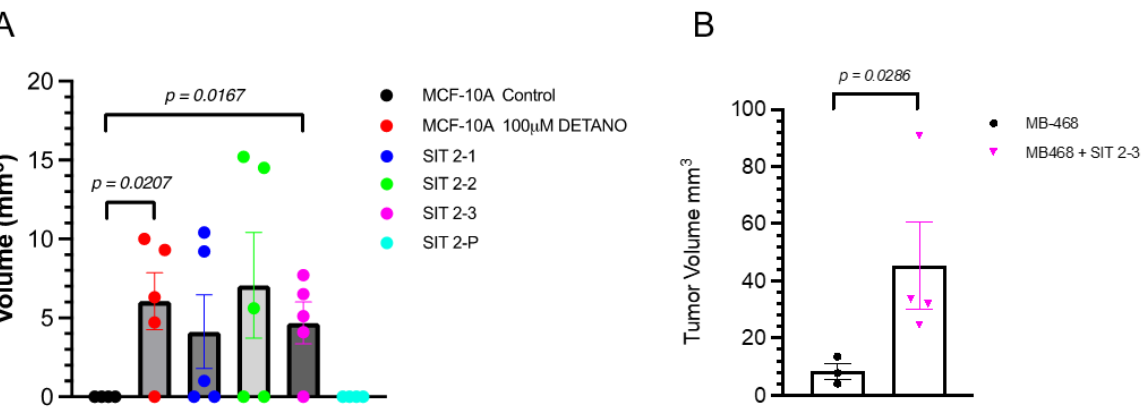
Figure 6. Assessment of the malignant growth potential of subclones in nude mice. ( A ) 100 µ M DETANO treated MCF10A parent cells, and the SIT 2-3 clonal population formed small masses in nude mice that were significantly larger than control untreated MCF10A cells. ( B ) When compared to MB-468 cells alone, MB-468 cells injected with SIT 2-3 cells formed significantly larger tumors. Mice were euthanized at 30 days post-cell injection.